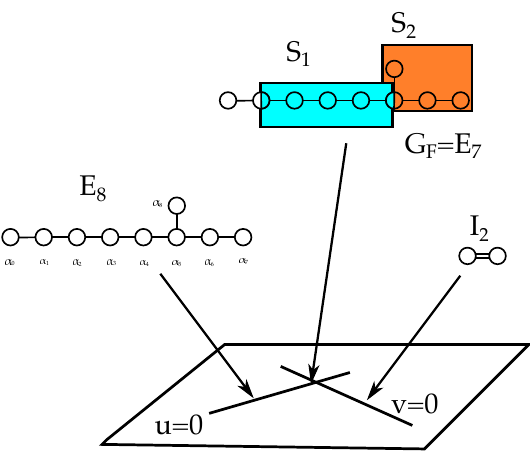
Figure 6 . Cartoon of a codimension two (cid:12)ber for the rank two E-string. S i are the two surface components of the non-(cid:13)at (cid:12)ber in codimension two. The rational curves (circles) that are fully contained in the surfaces contribute to the non-abelian (cid:13)avor symmetry, which in the shown example is G F = E 7